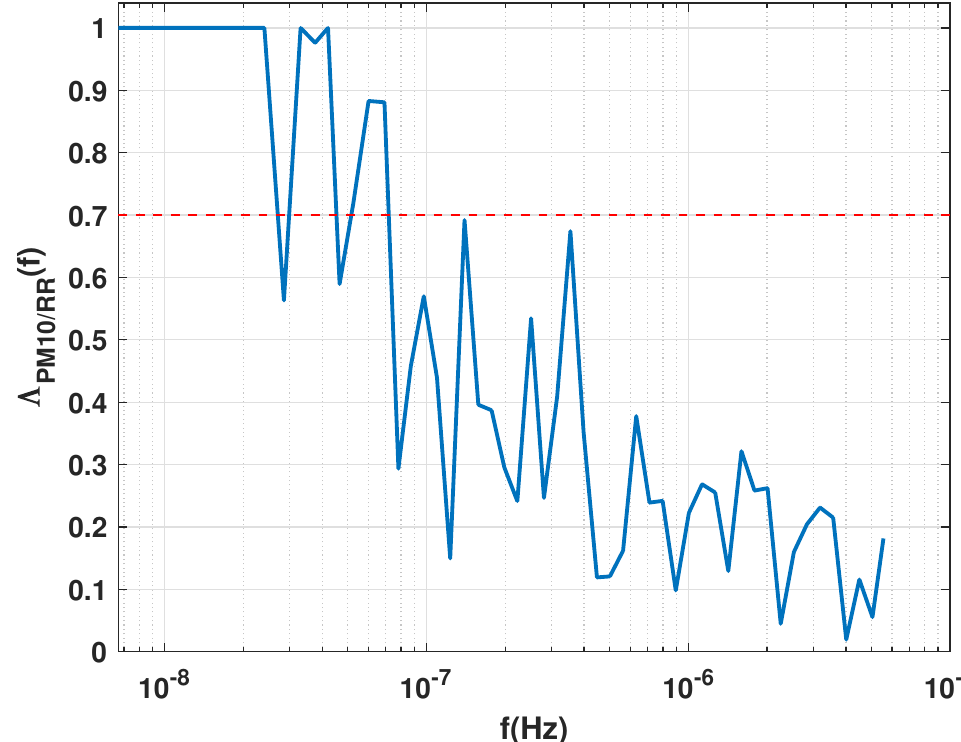
Figure 2. The coherence function Λ PM 10/ RR ( f ) in semilogx plot of synchronous measurements between PM 10 and RR over 11 years. The red horizontal dashed line indicates the significant correlation threshold ( Λ PM 10/ RR ( f ) ≥ 0.70)